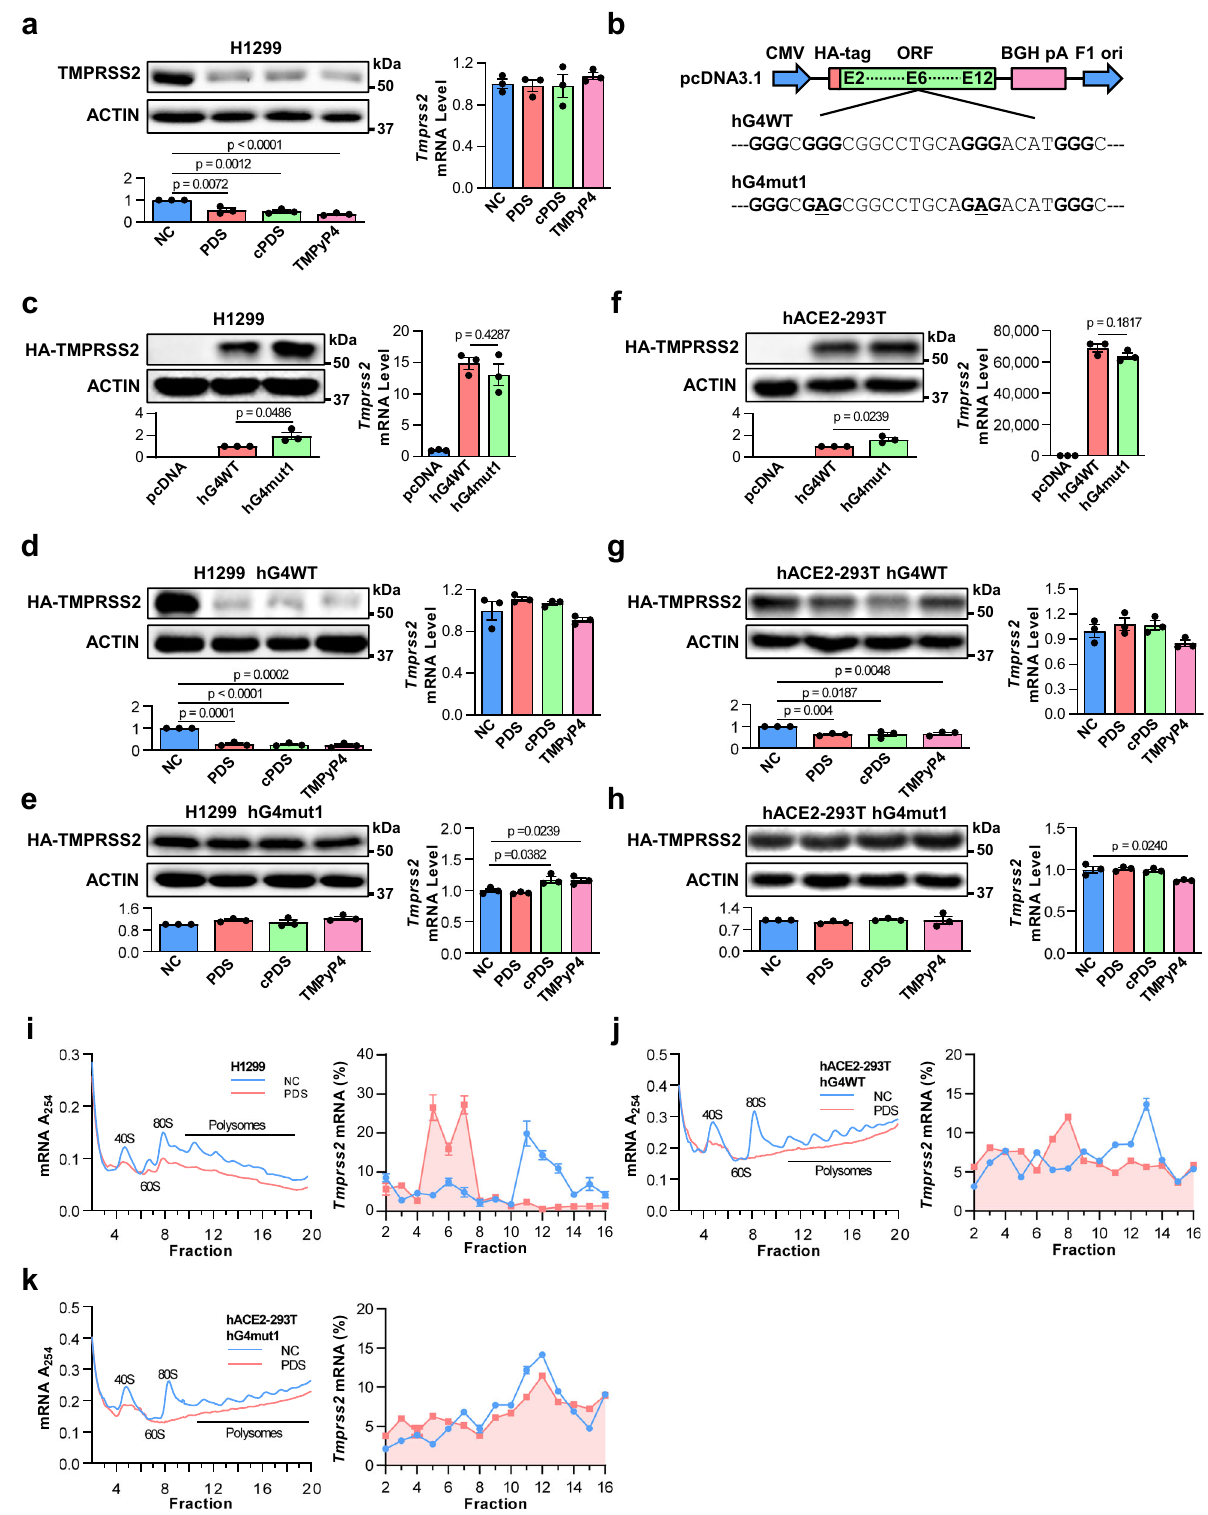
usage bias, we further constructed the hG4mut2 and hG4mut3 plasmids, in which Gs in the middle two G-tracts of GQS-675 were substituted with thymines (Ts) and cytosines (Cs), respectively (Supplementary Fig. 2l). Similar to hG4mut1, both hG4mut2 and hG4mut3 plasmids resulted in an increase in TMPRSS2 protein levels compared with the hG4WT plasmids, and this increase was not affected by RG4 stabilizers (Supplementary Fig. 2m), arguing against NATURE COMMUNICATIONS| (2022) 13:1444